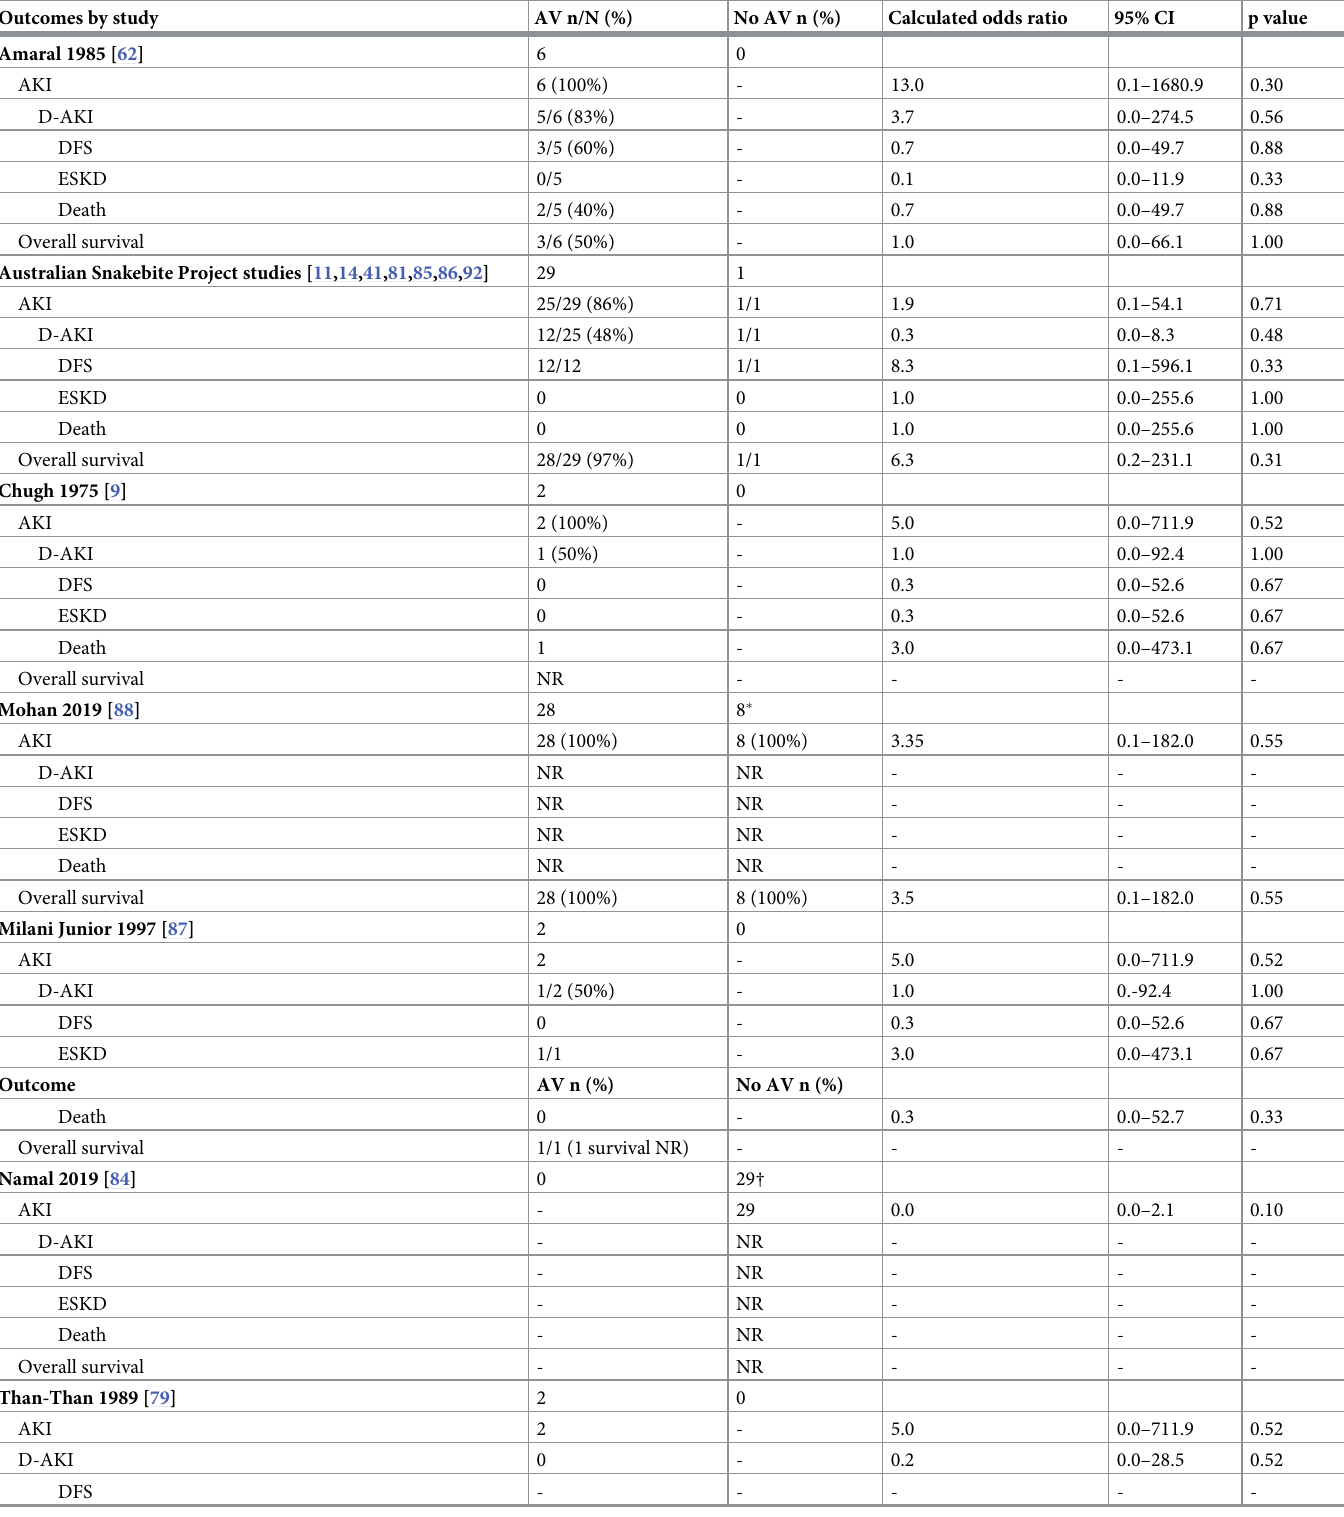
Table 3. Outcomes of AKI, DFS, death and overall survival for studies with a low risk of selection bias reporting intervention with antivenom. Outcomes by